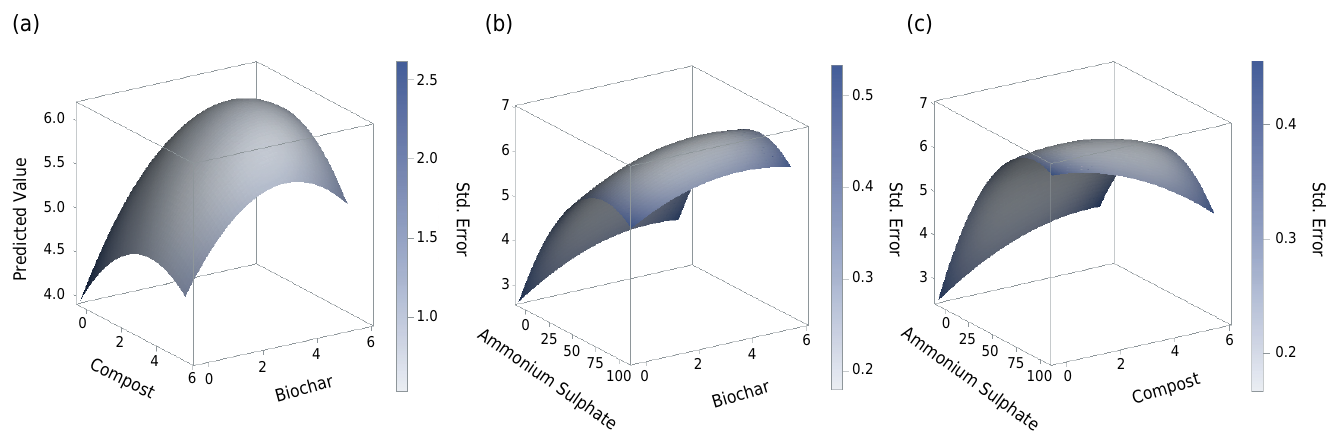
Figure 6. The NUE (kg kg -1 grain by N fertilizer ) response to independent variable: (a) biochar (t ha -1 ) and compost (t ha -1 ); (b) biochar (t ha -1 ) and ammonium sulphate (kg ha -1 ); (c) compost (t ha -1 ) and ammonium sulphate (kg ha -1